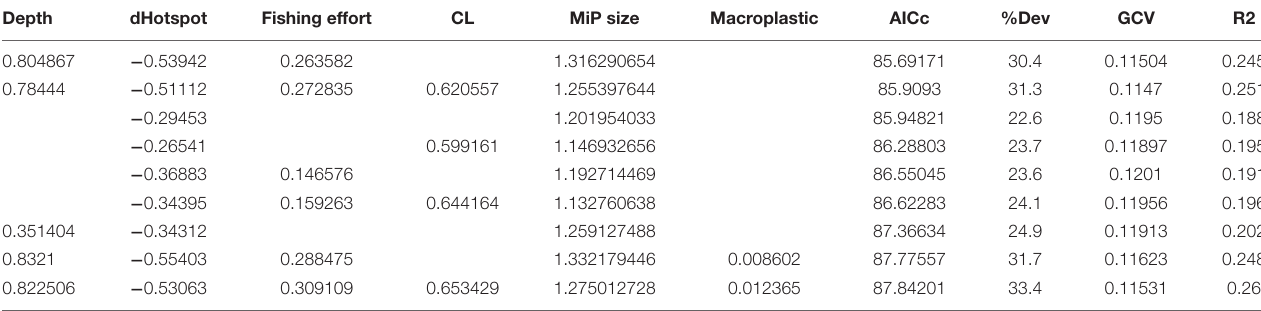
TABLE 3 | GAM models ordered according to the AIC lowest value. Depth dHotspot